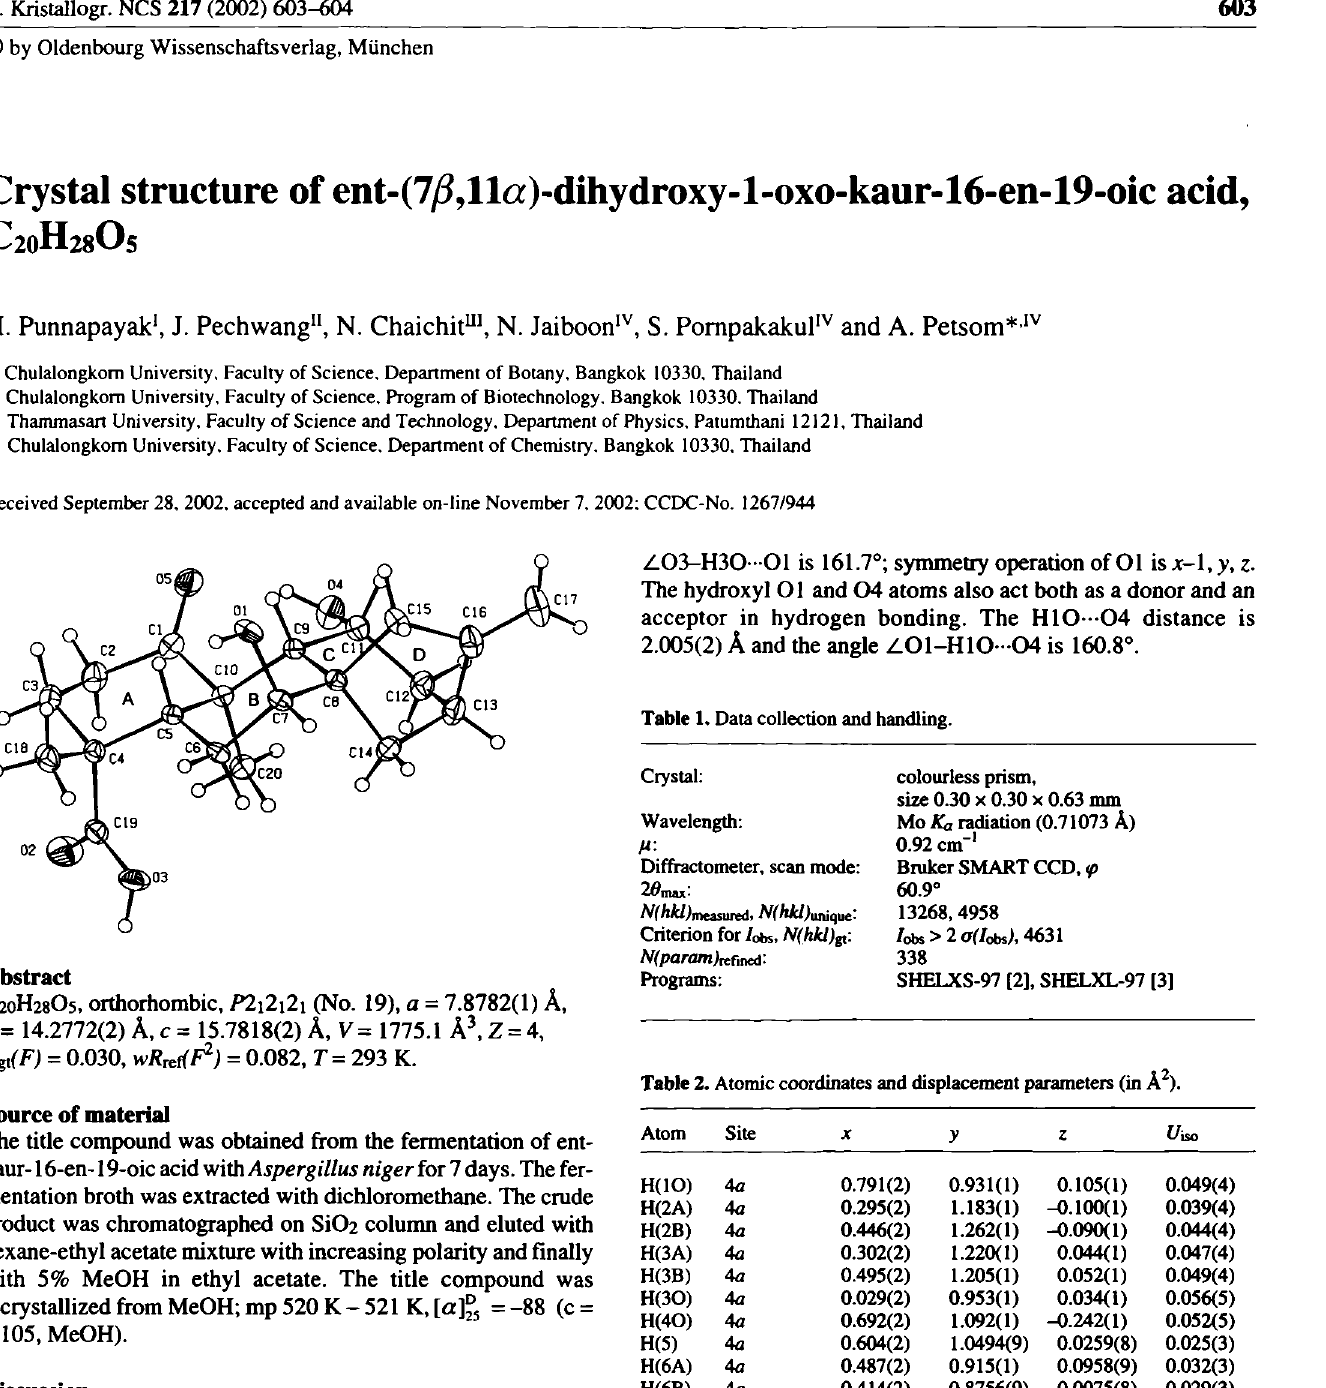
Table 2. Atomic coordinates and displacement parameters (in Â 2